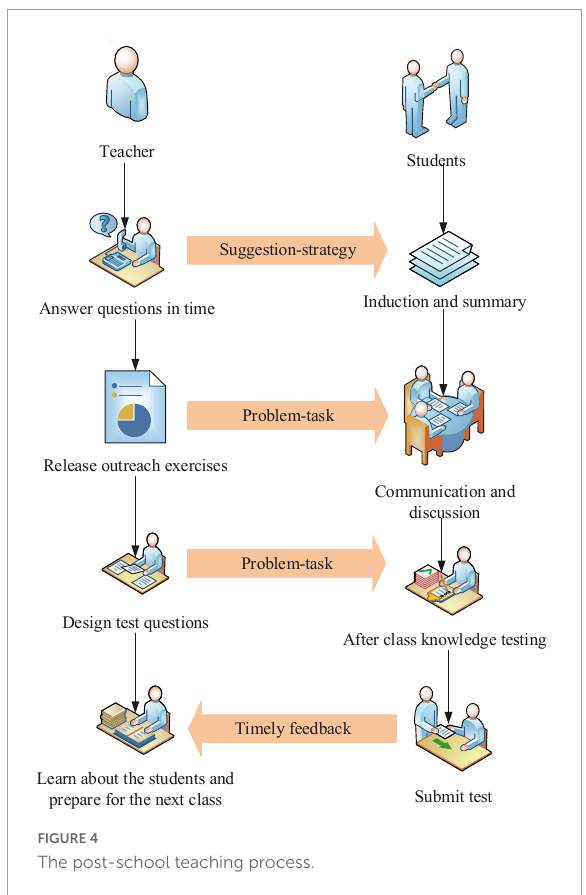
FIGURE4 The post-school teaching process.